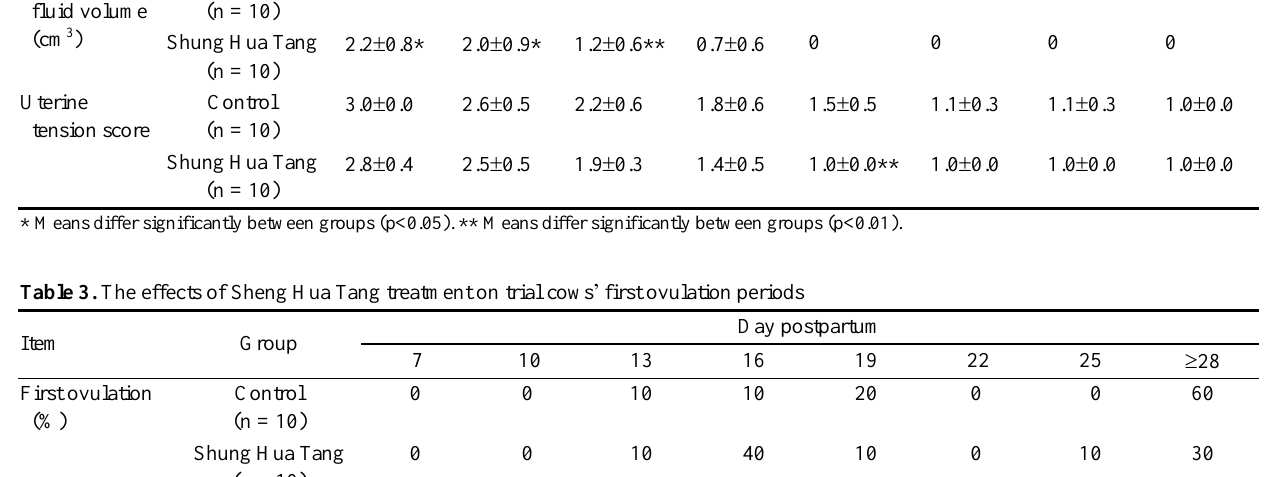
Table 2. The effects of Sheng Hua Tang treatment on trial cows’ intrauterine fluid volume and uterine tonicity Item